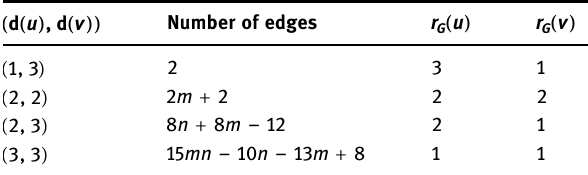
Table 2: Edge partition of Si C 2 3 - n m III ,